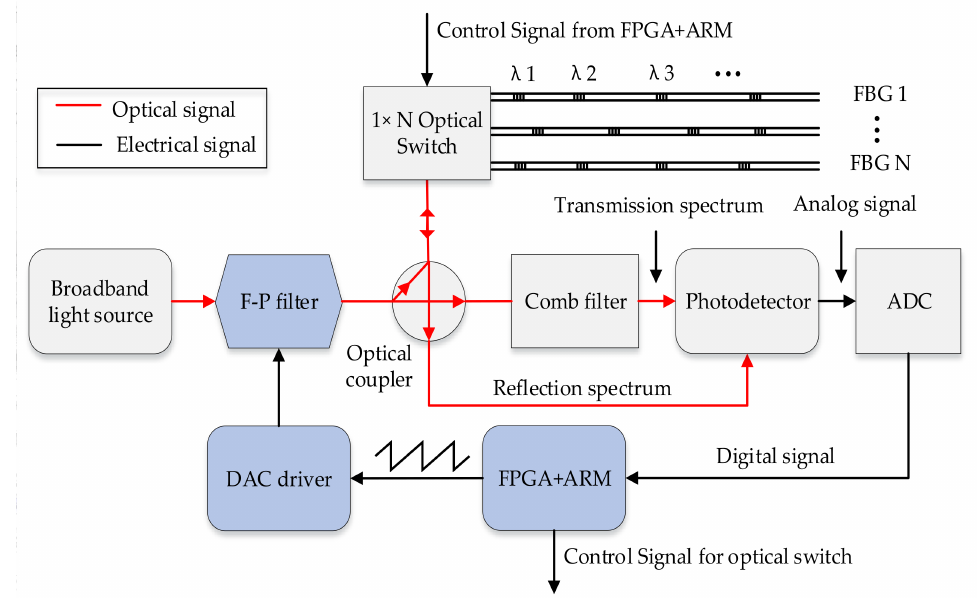
Figure 1. Schematic diagram of the FBG interrogation